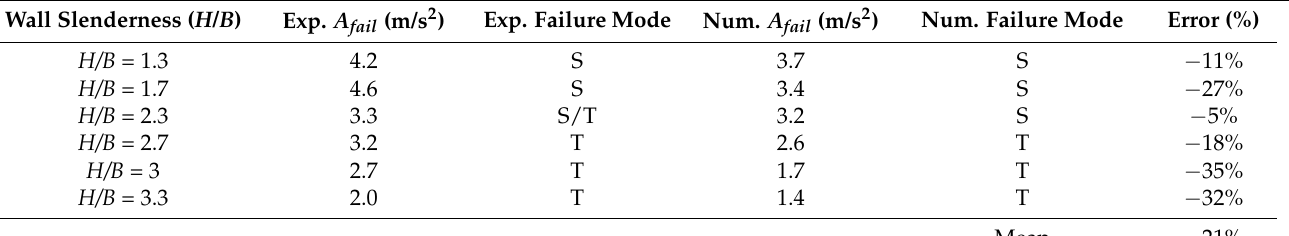
Table 3. Experimental and numerical acceleration at failure ( A fail ) for different wall slenderness: the mean value is given when several experimental points are available. The relative difference is computed by taking the experimental value as a reference. Finally, the detected failure modes are also indicated.